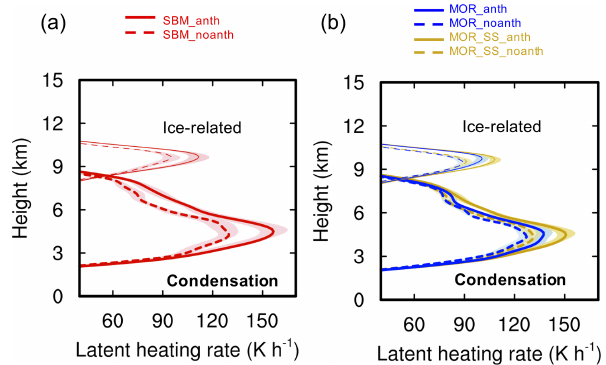
Figure 12. Vertical profiles of the condensation heating rate (thick lines below 9km; unit: Kh − 1 ) and the ice-related latent heating rate (thin lines above 9km; unit: Kh − 1 ) averaged over the top 25 percentiles (i.e., from the 75th to the 100th percentile) of the updrafts with a velocity greater than 2ms − 1 from the simula- tions (a) SBM_anth and SBM_noanth (red), (b) MOR_anth and MOR_noanth (blue), and MOR_SS_anth and MOR_ SS_noanth (orange) over the study area (red box in Fig. 7) during the strong convection period (20:00–23:00UTC on 19 June 2013). Data are processed in the same way as for Fig.